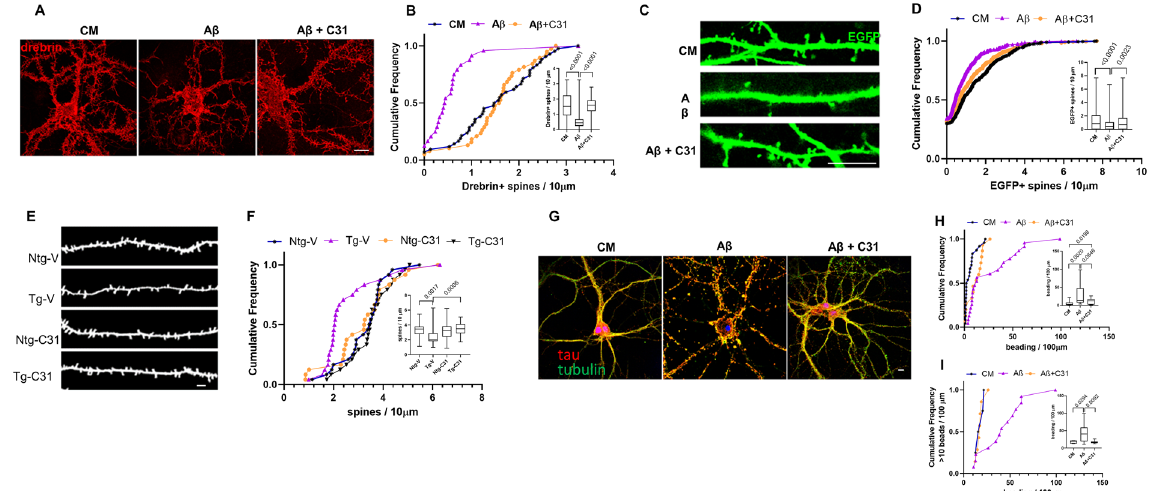
Figure 1. p75 NTR modulation mitigates Aβ-induced loss of spines and neurite injury. ( A–D ) 21 DIV hippocampal neurons were treated with CM, Aβ, or Aβ with 100 nM LM11A-31 and examined at 24 h following treatment. ( A ) Representative neurons stained for drebrin (red). ( B ) Quantitation of numbers of drebrin- positive spines per length of dendrite segment, displayed in cumulative frequency and ( inset ) box plots, with p values above the boxes from KS testing of indicated comparisons. n = 24–38 neurites per condition from a total of 3 independent experiments. ( C ) Dendritic spines of EGFP-transfected hippocampal neurons (green) were visualized at 24 h post-Aβ exposure. ( D ) Dendritic spine density quantitated and displayed as in ( B ). n = 36–43 neurons per condition from a total of 9 independent experiments. ( E , F ) 7.5–8.0-month-old non-transgenic mice (Ntg) and AβPP L/S mice (Tg) were treated with either vehicle (V) or LM11A-31 (C31) by oral gavage for 3 months, at which time spine density of hippocampal CA1 neurons was determined in Golgi-stained dendrites using MBF Neurolucida. ( E ) Representative traced dendritic spine images. ( F ) Quantitative analysis of the dendritic spine density displayed as in ( B ). 3 neurons from each of 6 mice were analyzed from each treatment group (n = 18/group). Scale bars in each image, 10 µm. To assess neuritic injury, neurons were immunostained for tau (red) and tubulin (green) and discrete yellow regions (‘beads’), reflecting co-accumulation of tau and tubulin, were manually counted and expressed as number of beads/100 µm neurite beads. Scale bar, 10 µm ( G ). ( H ) Cumulative frequency analysis shows a population of higher-count segments in Aβ-treated cells not observed in the presence of C31 or without Aβ. Inset displays box plots with p values from KS testing for the indicated comparisons. ( I ) Analysis of distributions of high-count segments (> 10 beads/100 µm). n = 12–14 neurites/group derived from a total three independent